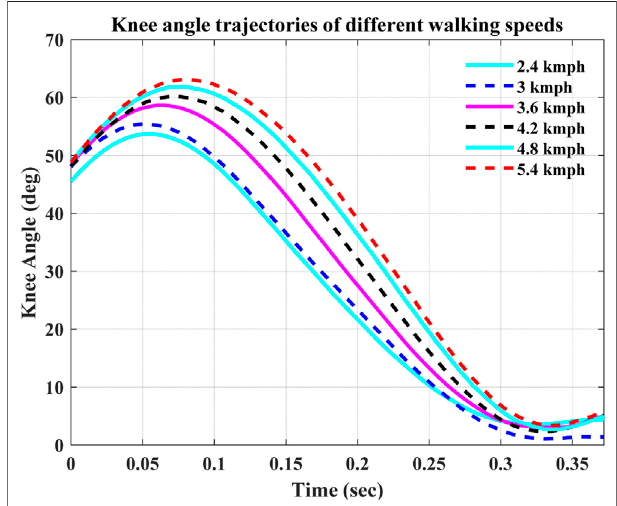
FIGURE9| Kneeangletrajectoriesatdifferentwalkingspeeds(Ekkachai et al., 2014).